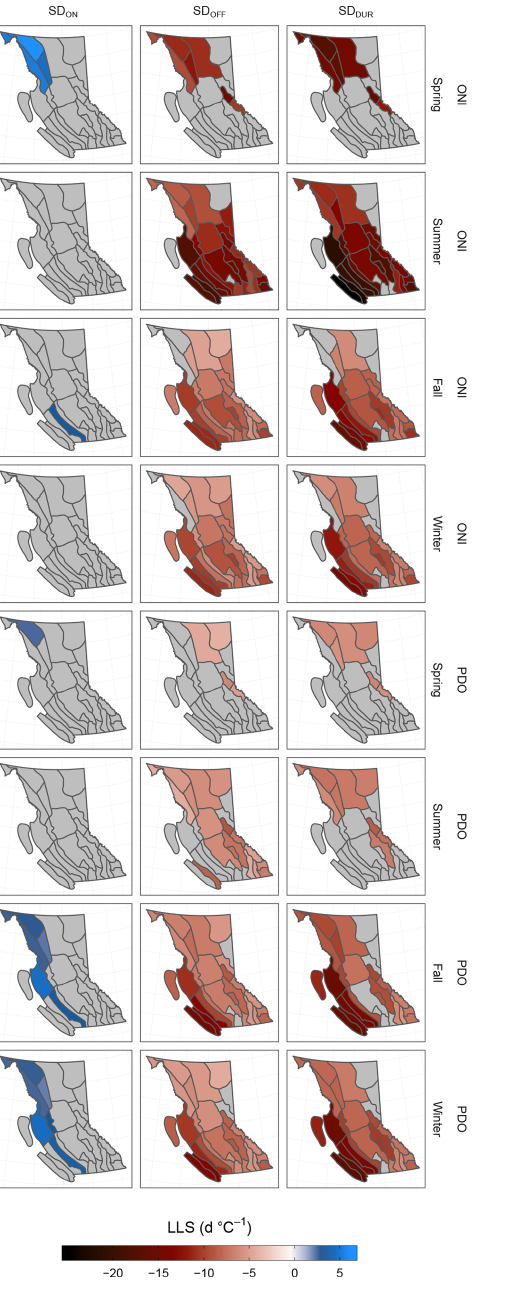
Figure 10. Map of BC showing the linear least squares (LLS) rate of change in days per degree Celsius anomaly (d ◦ C − 1 ; left) and Spearman correlation coefficients (right) for SD ON , SD OFF , and SD DUR (per column) with seasonal (spring, summer, fall, winter) ONI and PDO values (per group of four rows) by hydrozone. Grey zones have insignificant trends ( p > 0 . 05). Use Fig. 1 for spatial reference. See the Supplement for raw values and error